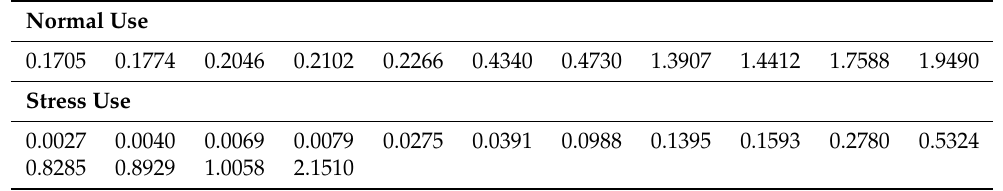
Table 1. Oil breakdown times of insulating